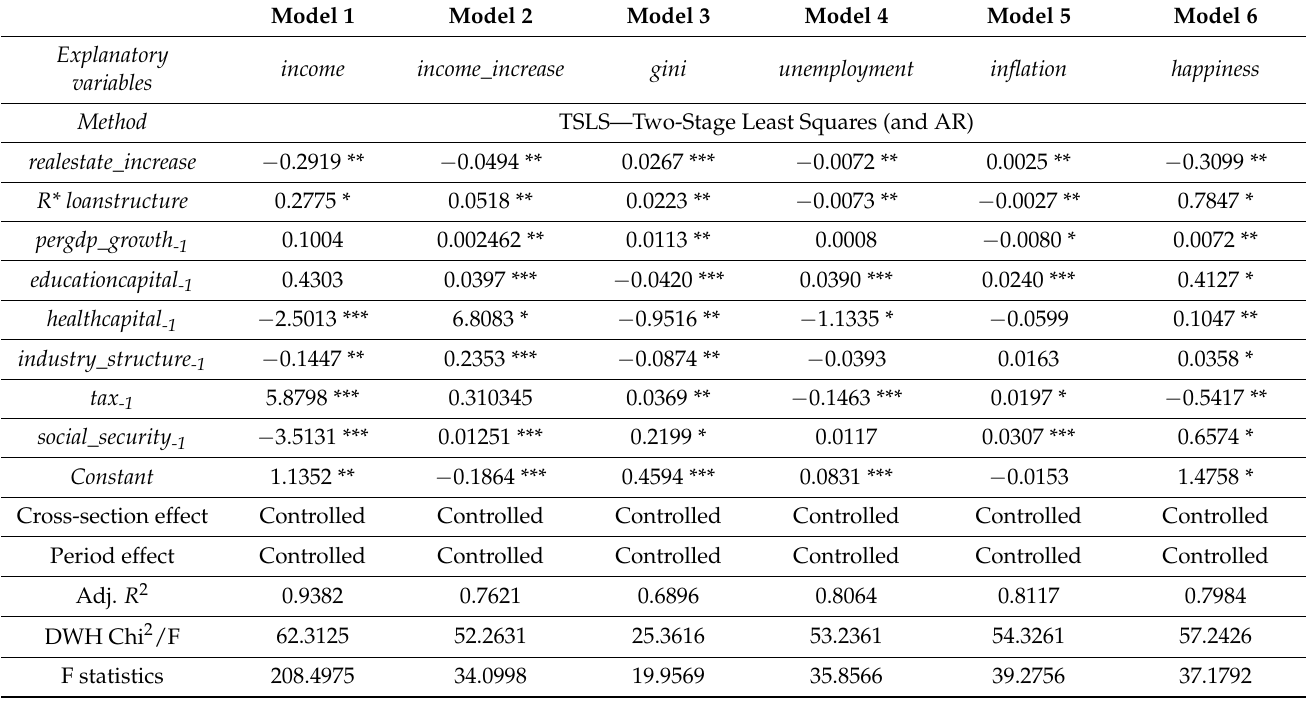
Table 4. TSLS test results of the impact of real estate investment through the loan preference on national